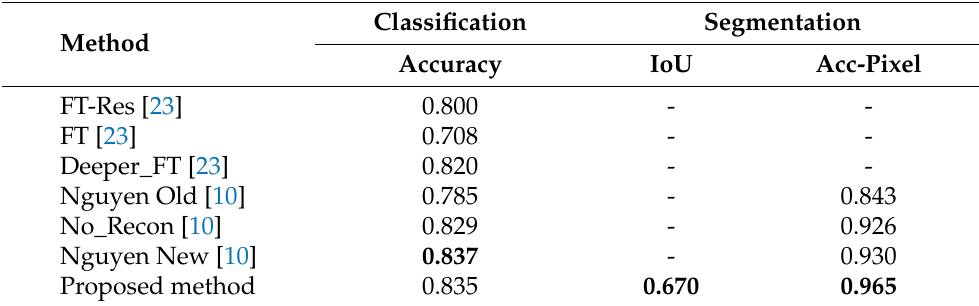
Table 10. Comparison of the results to detect C23 crop images altered by FaceSwap manipulation methods using Face2Face -based models and fine-tuned with FaceSwap . In this table, acc-pixel stands for pixel-wise